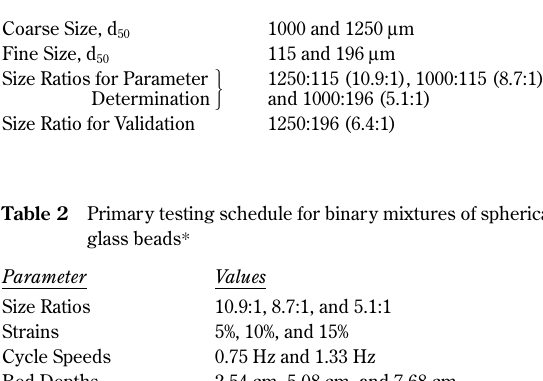
Table 1 Summary of size ratios of glass beads used for this study